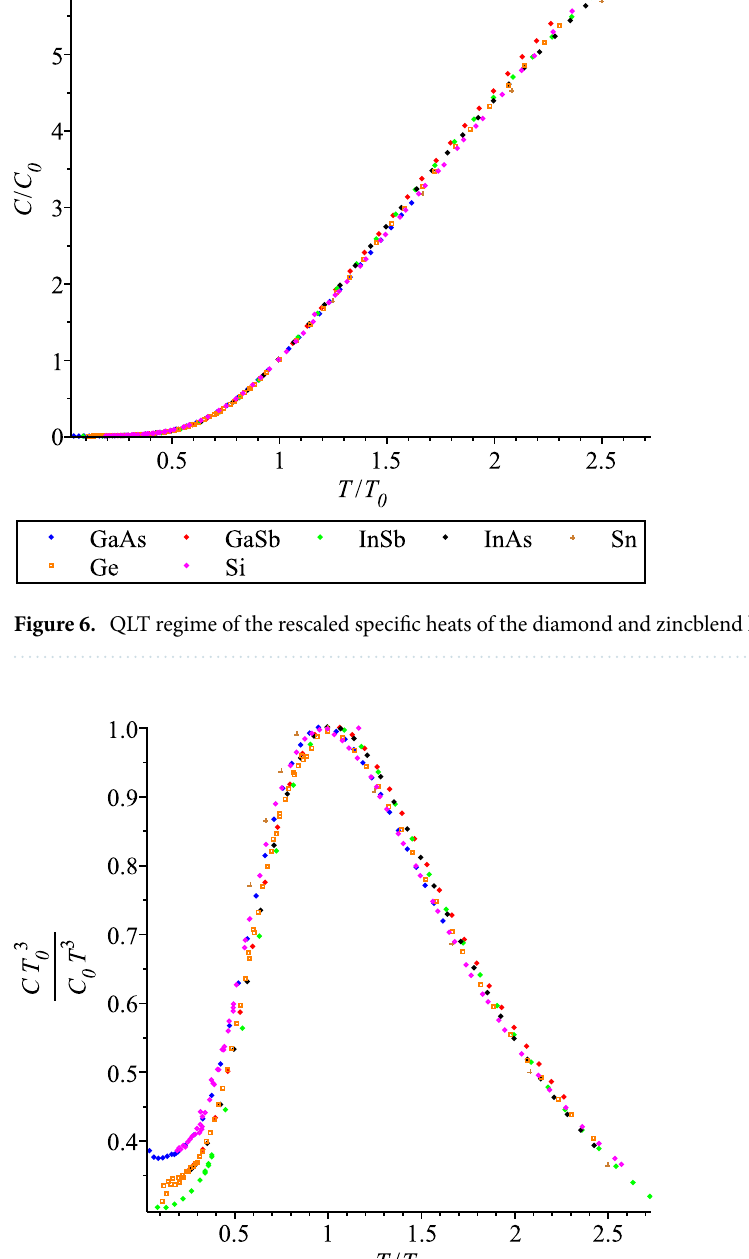
Figure 7. QLT regime of the rescaled C / T